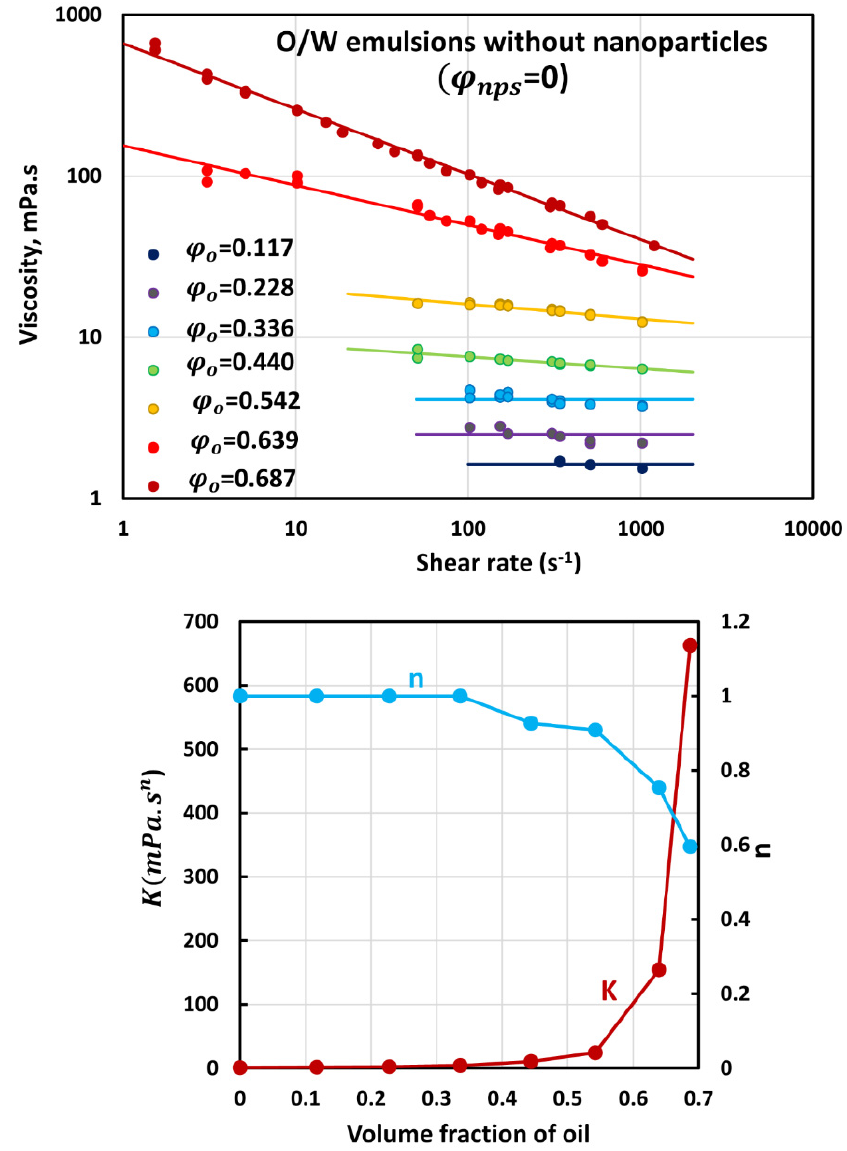
Figure 5. Viscous behavior of O/W emulsions without nanoparticles.